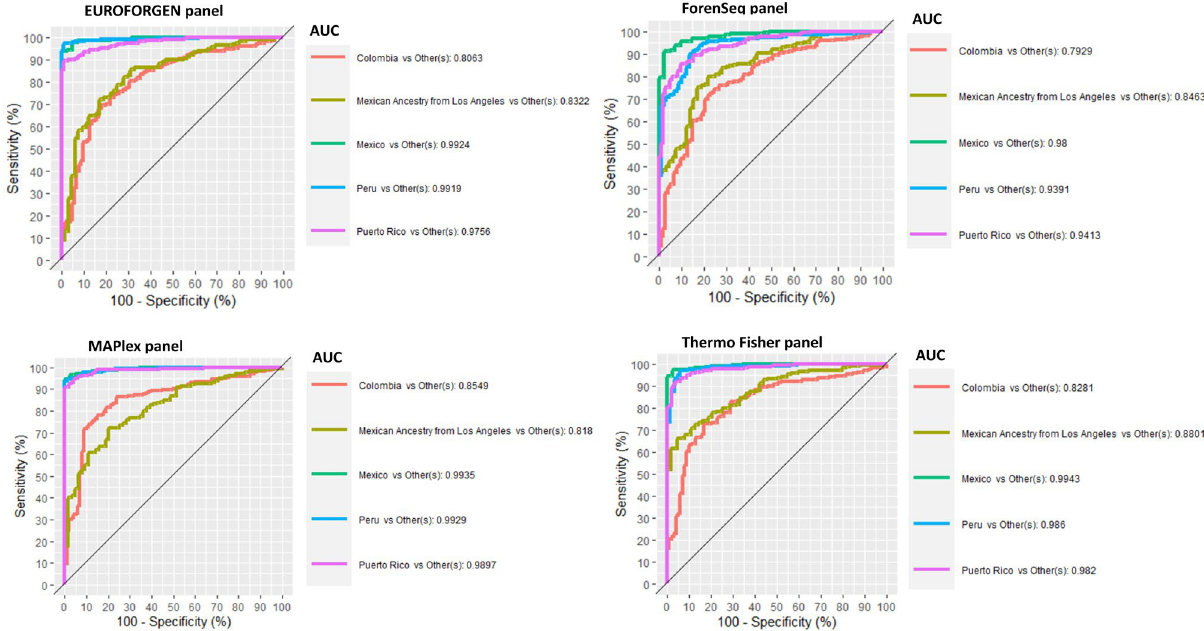
Figure 9. ROC curves, sensitivity, specificity, and AUC values for American countries and populations.